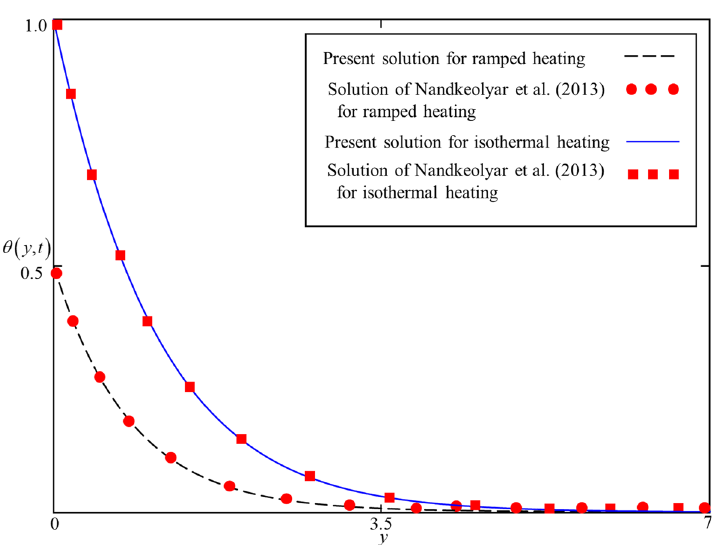
Figure 2. Comparison of present solutions presented in Eqs. (83), (86) and Nandkeolyar et al. . 45 , Eq. (19) for t = 0.5, 1.5